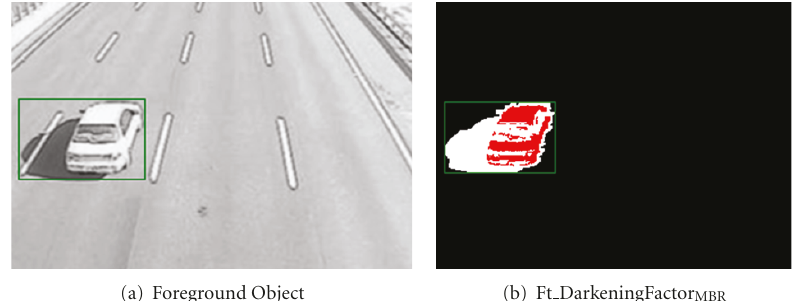
Figure 20: An example of gray level-based nonshadow foreground-pixel